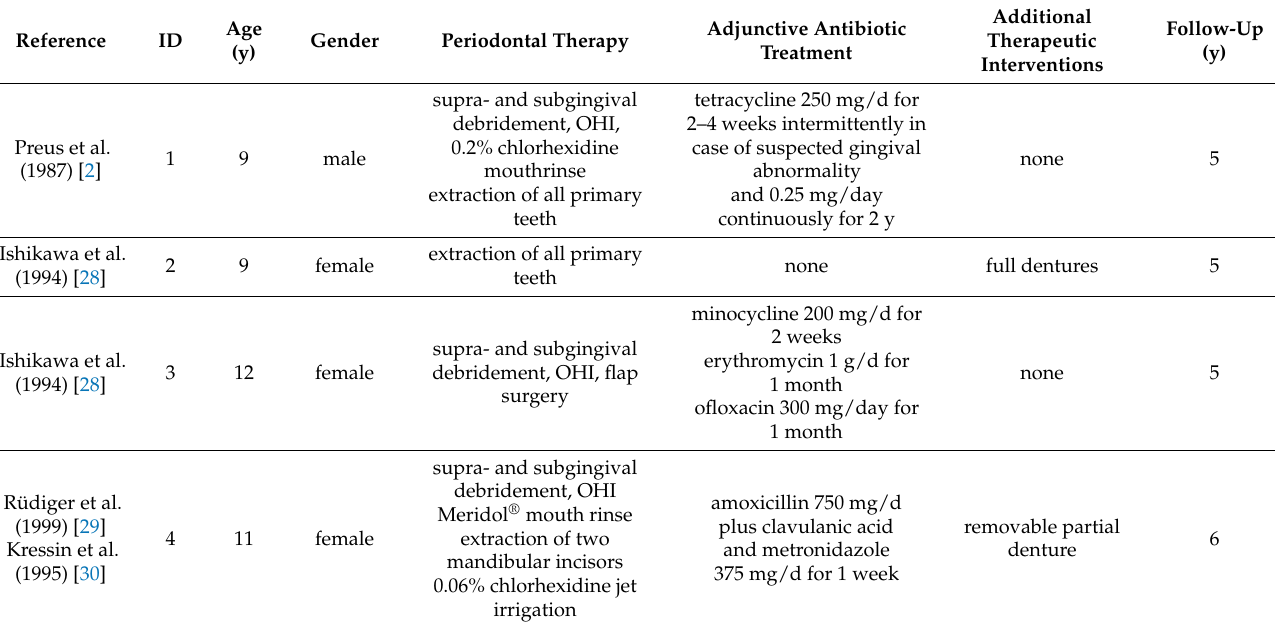
Table 1. Subjects’ characteristics including gender, age at the end of follow-up, periodontal therapy, and follow-up interval of included cases with successful periodontal treatment. Clinical diagnosis of Papillon–Lef è vre syndrome was based on severe periodontitis in early childhood and palmoplantar hyperkeratosis in all of the included individuals. Successful periodontal treatment was defined as the loss of less than four permanent teeth because of periodontitis and arrest of periodontitis with steady probing depths ≤ 5 mm for ≥ 24 months. Multiple reports existed from individuals with IDs 4, 5, 6, and